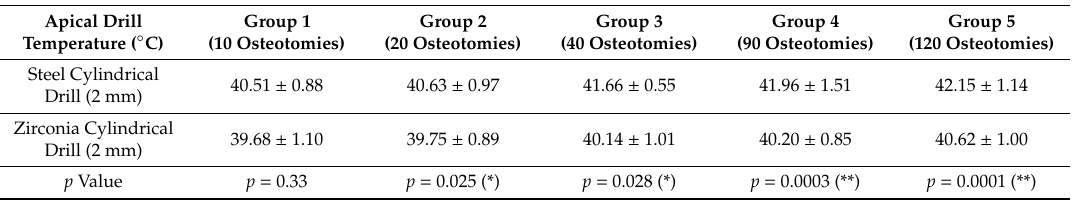
Table 2. Summary of the apical drill temperature after bone site preparation (mean ± standard deviation).